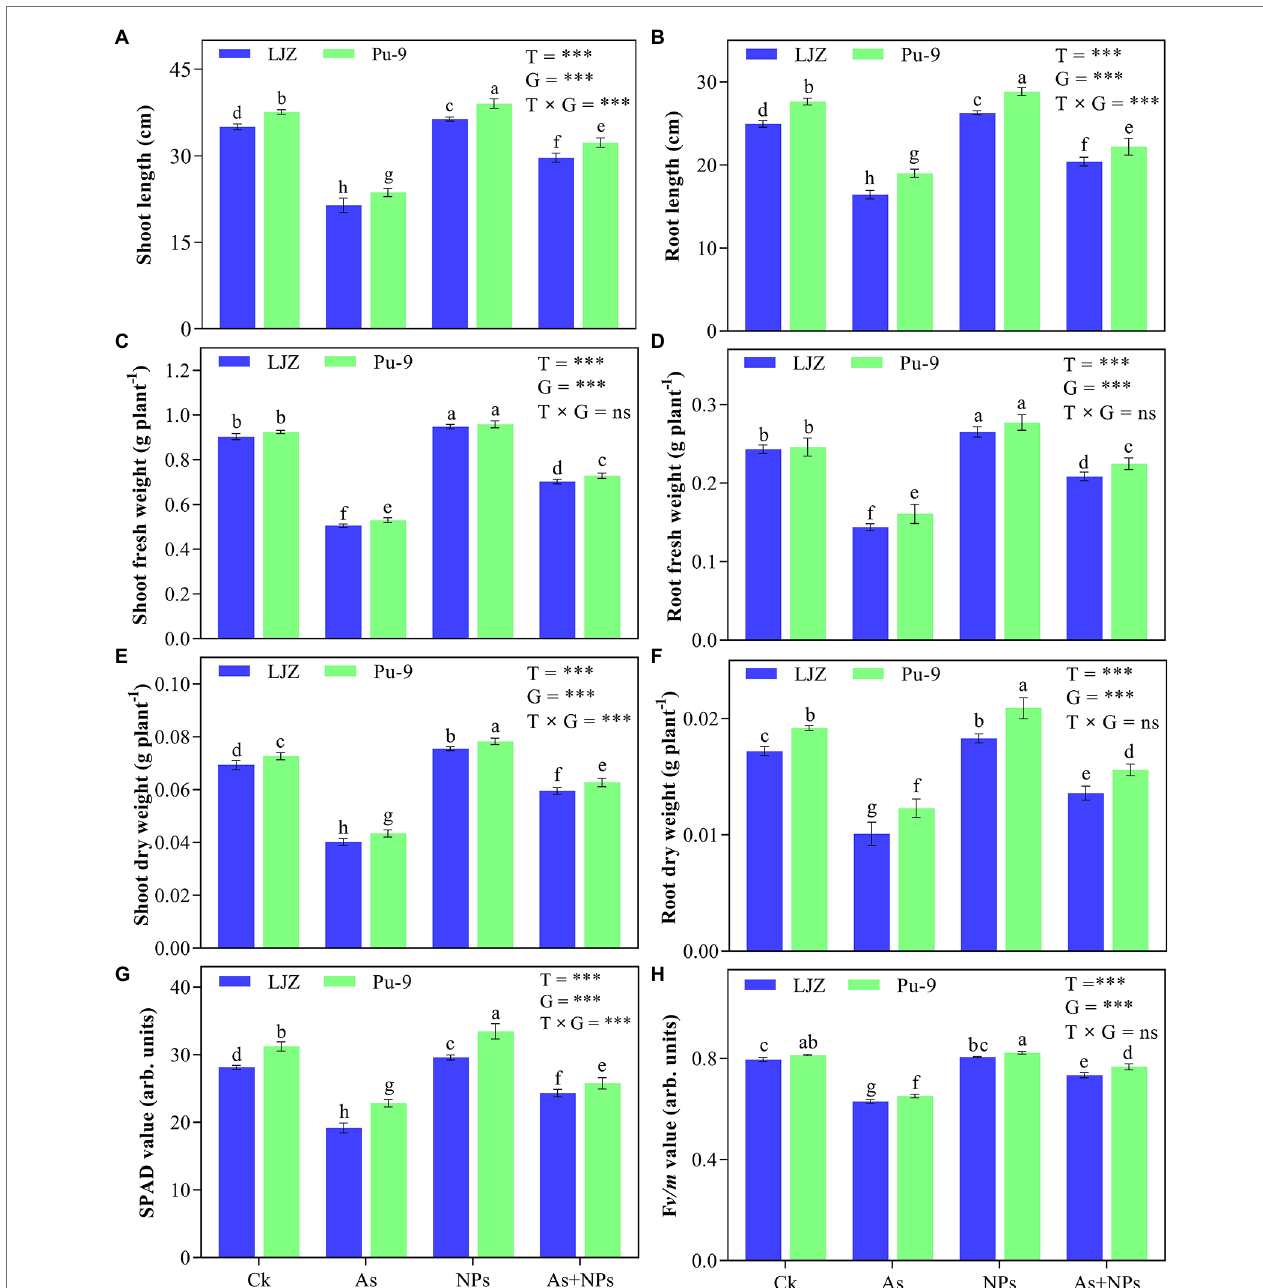
FIGURE 2 | Effects of different treatments on plant growth and chlorophyll contents. (A,B) shoot and root length; (C,D) fresh weight of shoots and roots; (E,F) dry weight of shoots and roots. (G) , SPAD value; (H) , maximum quantum efficiency (Fv/m) of photosystem II. Vertical bars represent the mean ± SD of four independent replicates. Different letters above error bars indicate the significant difference between treatments and genotypes at p ≤ 0.05. T, treatment; G, genotype; T × G, the interaction between treatment and